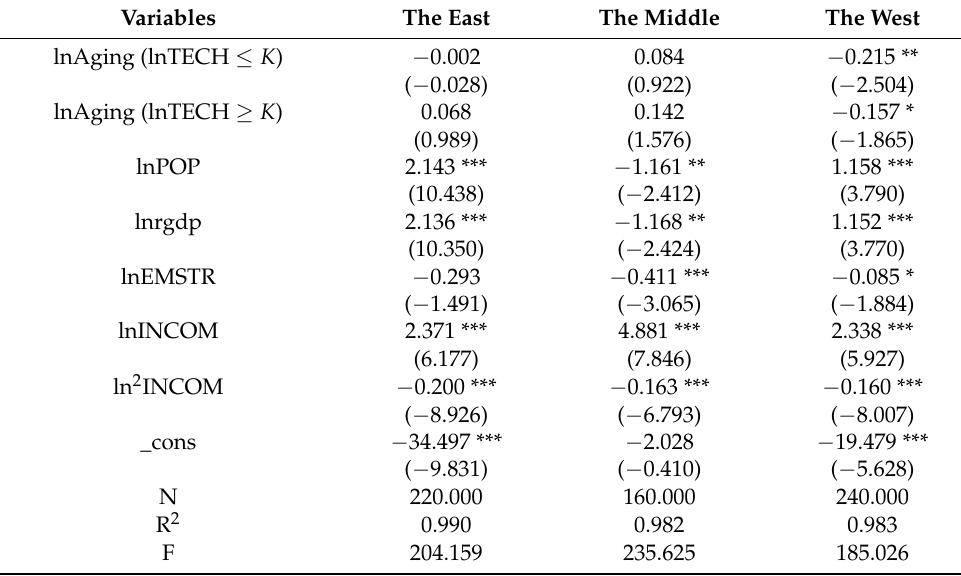
Table 12. Threshold effect of technological innovation level on the impact of population aging on carbon emissions in the eastern, central and western regions. Variables The East The Middle The West lnAging (lnTECH ≤ K ) − 0.002